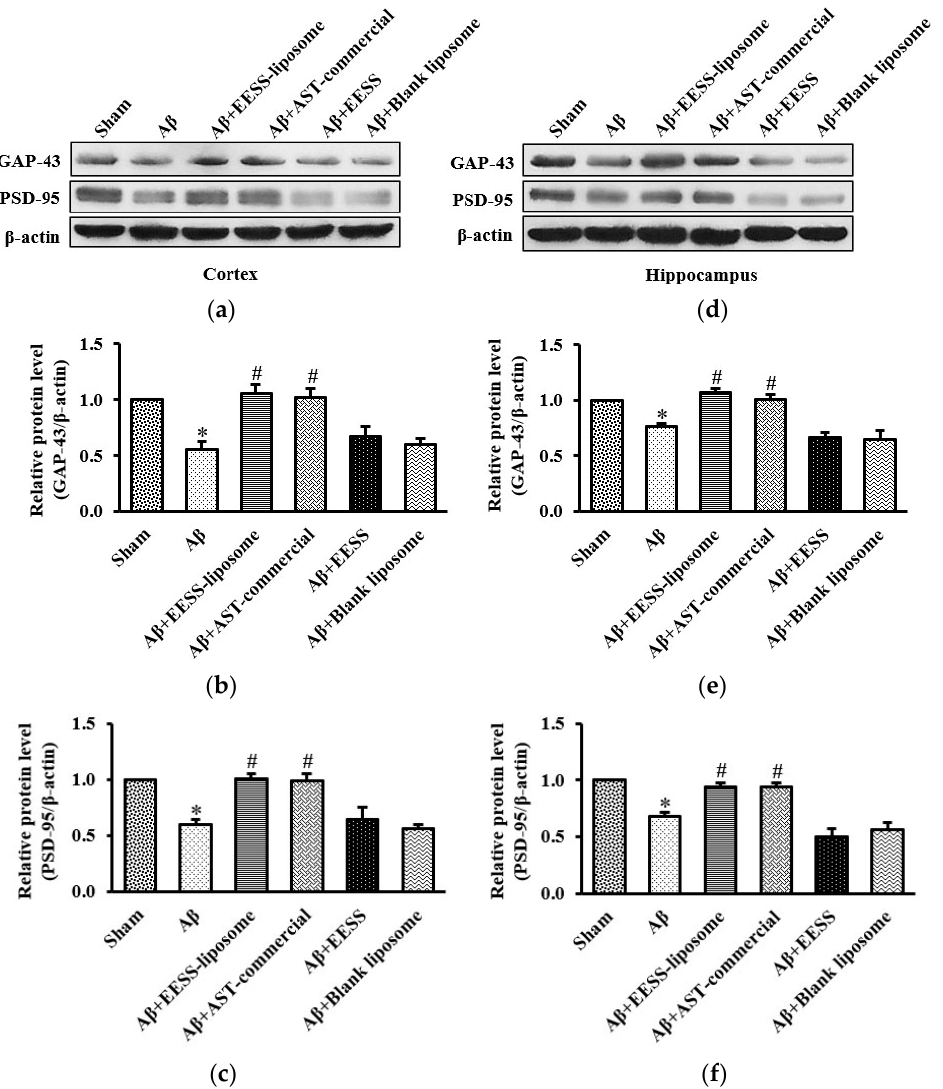
Figure 9. EESS-loaded liposome ameliorated A β -suppressed GAP-43 and PSD-95 synaptic plasticity proteins. ( a , d ) show representative images of Western blot analysis of GAP-43 and PSD-95 in the cortex and hippocampus, respectively. ( b , e ) show the relative GAP-43 levels in the cortex and hippocampus, respectively. ( c , f ) show the relative PSD-95 levels in the cortex and hippocampus, respectively. Data were presented as means ± SEM. * indicates significant difference ( p < 0.05) between A β and sham groups; # indicates significant difference ( p < 0.05) between EESS-loaded liposome, AST-commercial and A β groups; n = 5 rats/group.